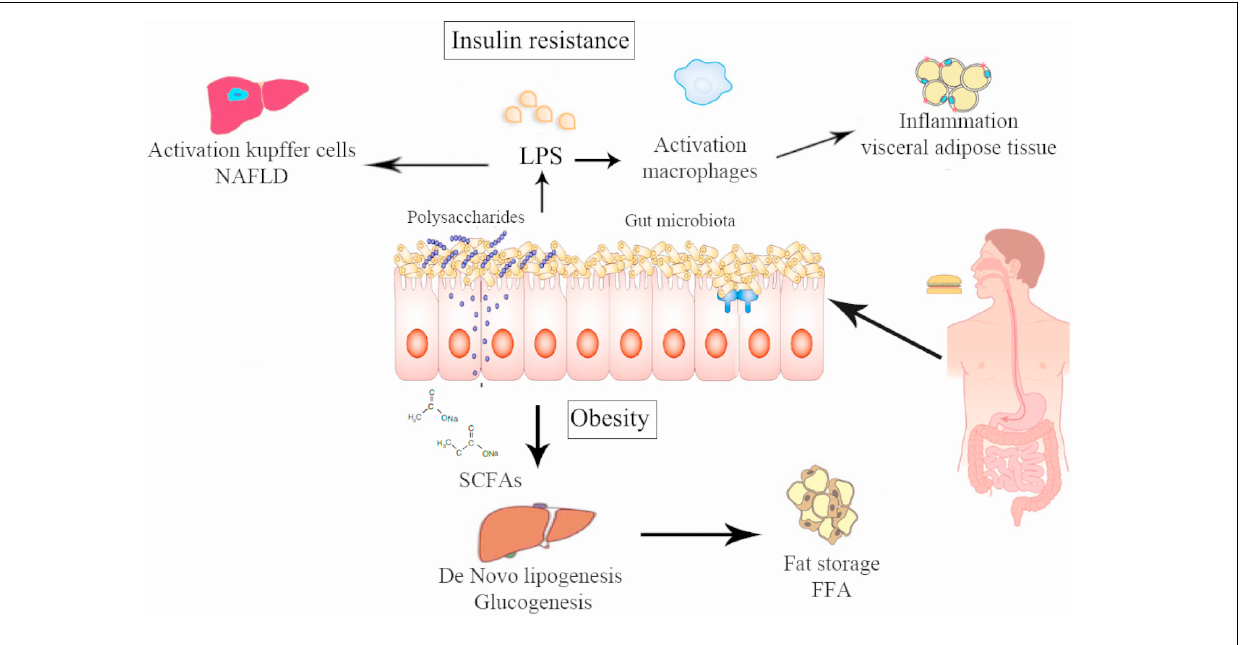
FIGURE 2 | Pathways via which intestinal microbiota can alter human metabolism producing obesity and insulin resistance. (1) Chronic bacterial translocation due to increased intestinal permeability that can drive a systemic inflammation leading to macrophage influx into visceral adipose